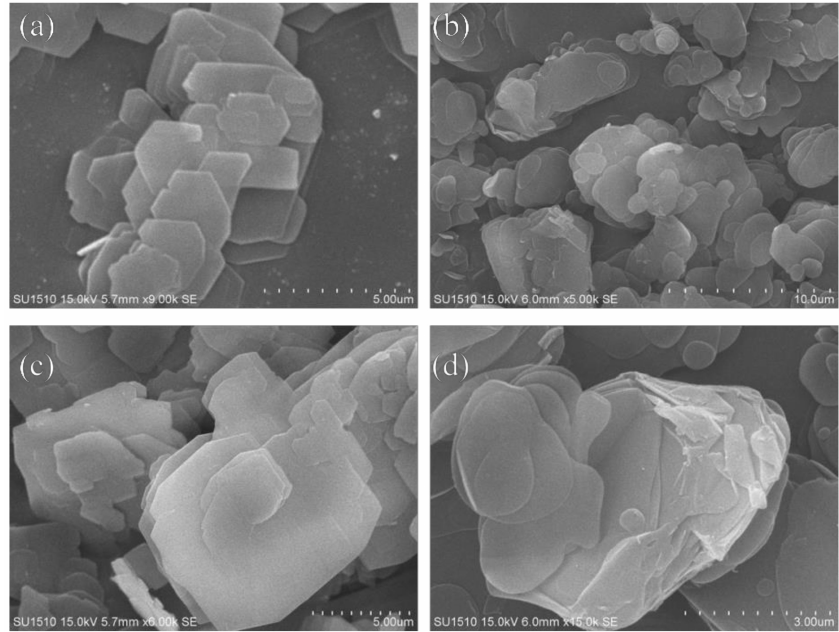
Figure 5. SEM images of ( a ) RUB-36, ( b ) IEZ-CDO, ( c ) Fe-IEZ-CDO and ( d ) Fe-IEZ-Al-CDO. Reprinted with permission from ref. [49]. Copyright 2020,